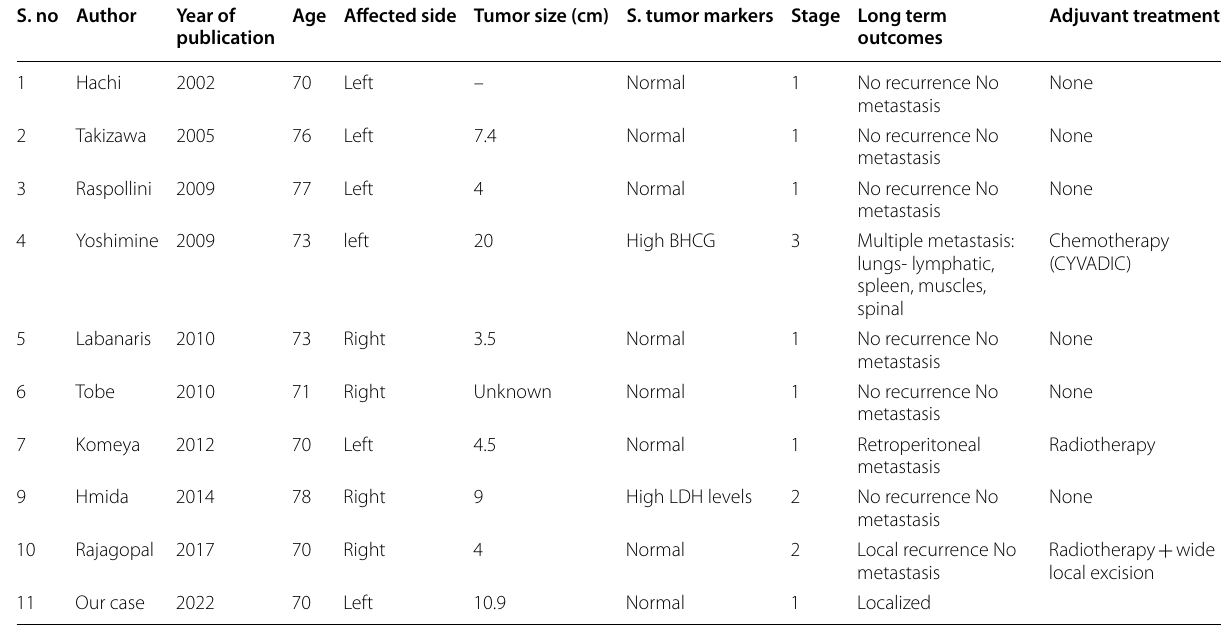
Table 1 A review of literature worldwide for clinical, biological and anatomopathological results of intratesticular Leiomyosarcomas in men aged > 70 years